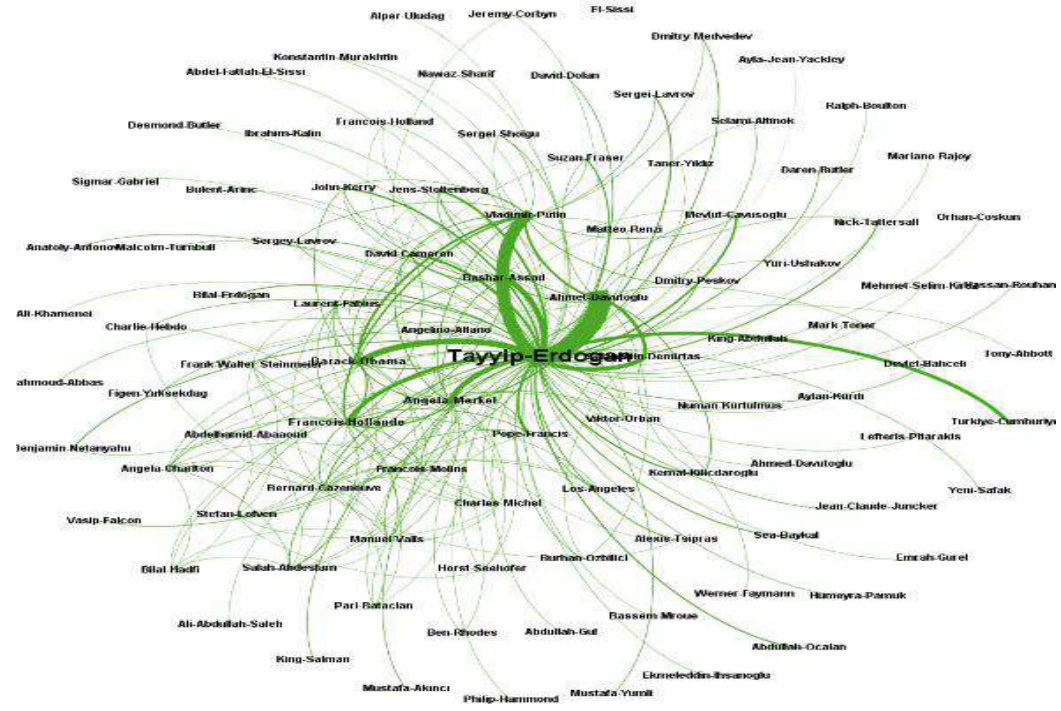
Figure 2: 2015 Network (Source: Authors ‟